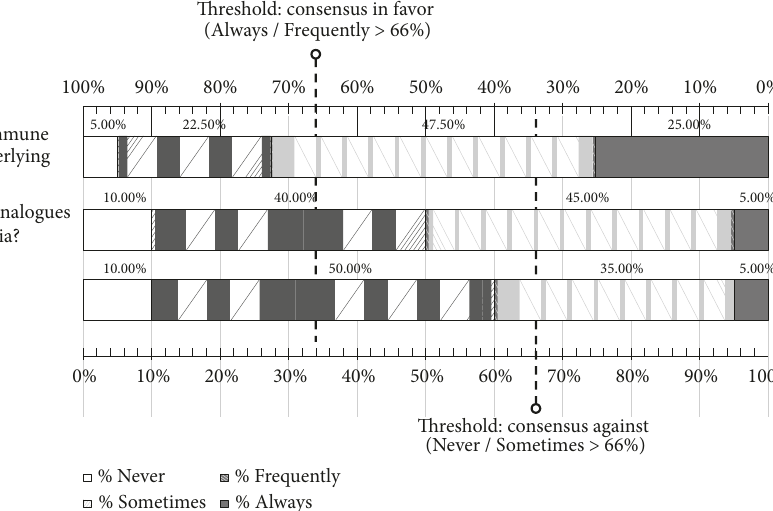
Figure 6: Results obtained in the section of the questionnaire regarding secondary immune thrombocytopenia. Distribution of the percentages of